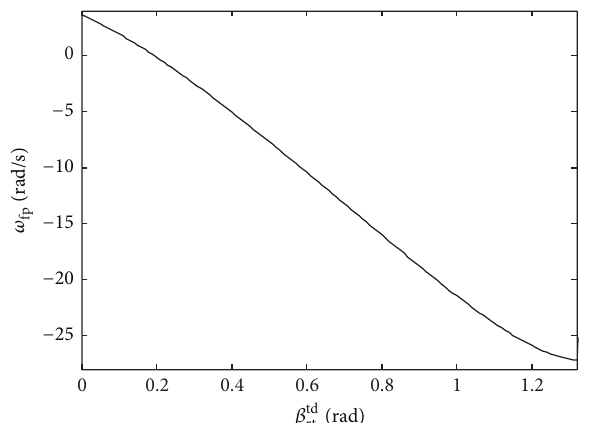
Figure 6: Pitching angular velocities during the flight phase.